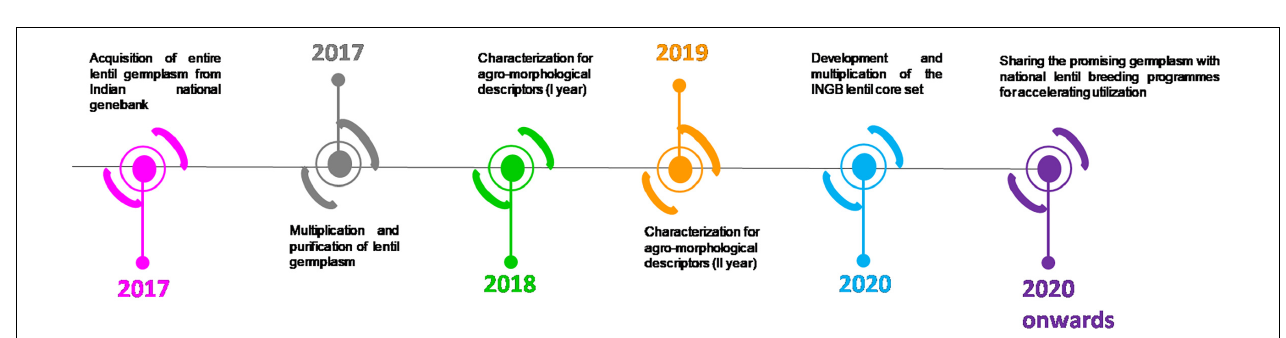
FIGURE 1 | Indigenous lentil collection sites of national genebank from different agro-ecological zones.